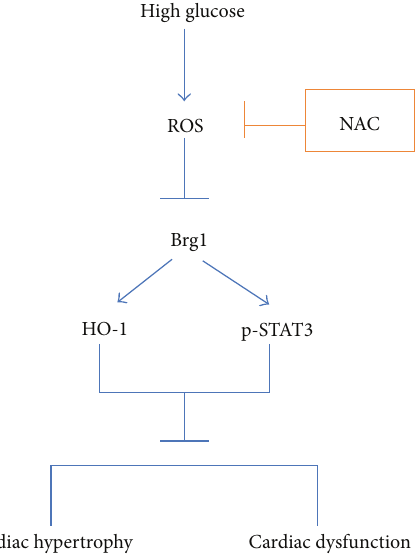
Figure 3: Schematic diagram proposing that Enhancement of cardiac Brg1 expression represents a novel mechanism whereby antioxidant N-acetylcysteine (NAC) enhanced cardiac HO-1 and p- STAT3 expression, and attenuated cardiac diastolic dysfunction in